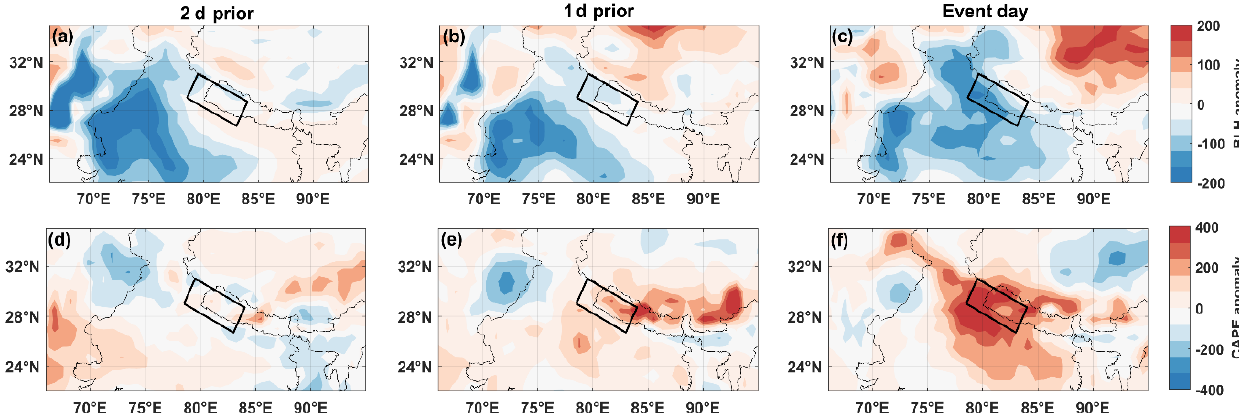
Figure 3. Composites of BLH anomaly (a–c) , in units of metres at 12:00UTC, and CAPE anomaly, in units of Jkg − 1 (d–f) at 12:00UTC, for the event days (c, f) and 1d prior (b, e) and 2d prior (a, d) to the events.